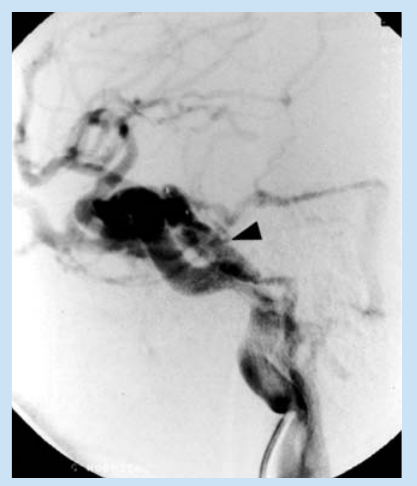
Fig. 4a. Lateral internal carotid angiogram showing fistula and dilated inferior petrosal sinus (arrow). The origin of the fistula was most likely from the posterior aspect of the cavernous part of the carotid artery. Transarterial placement of the bal- loon was unsuccessful despite multiple